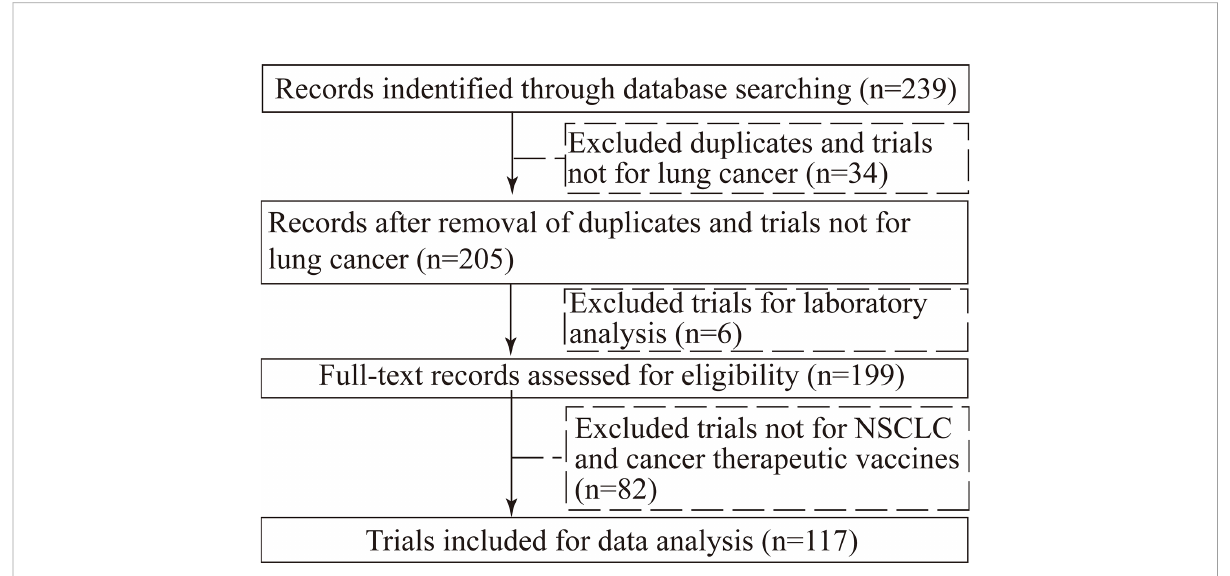
FIGURE 1 Flowchart of selection